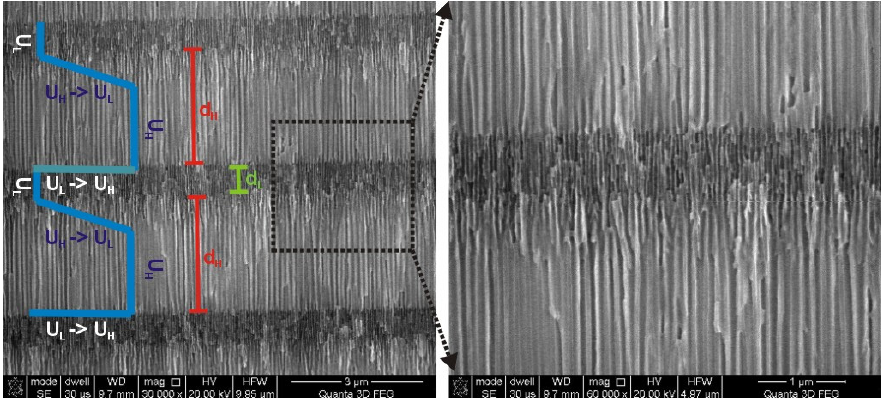
Figure 6. The U H ̶ ˃ U L and U L ̶ ˃ U H interfaces in the PAA—30 °C DBR. Figure 6. The U H U L and U L U H interfaces in the PAA—30 ◦ C